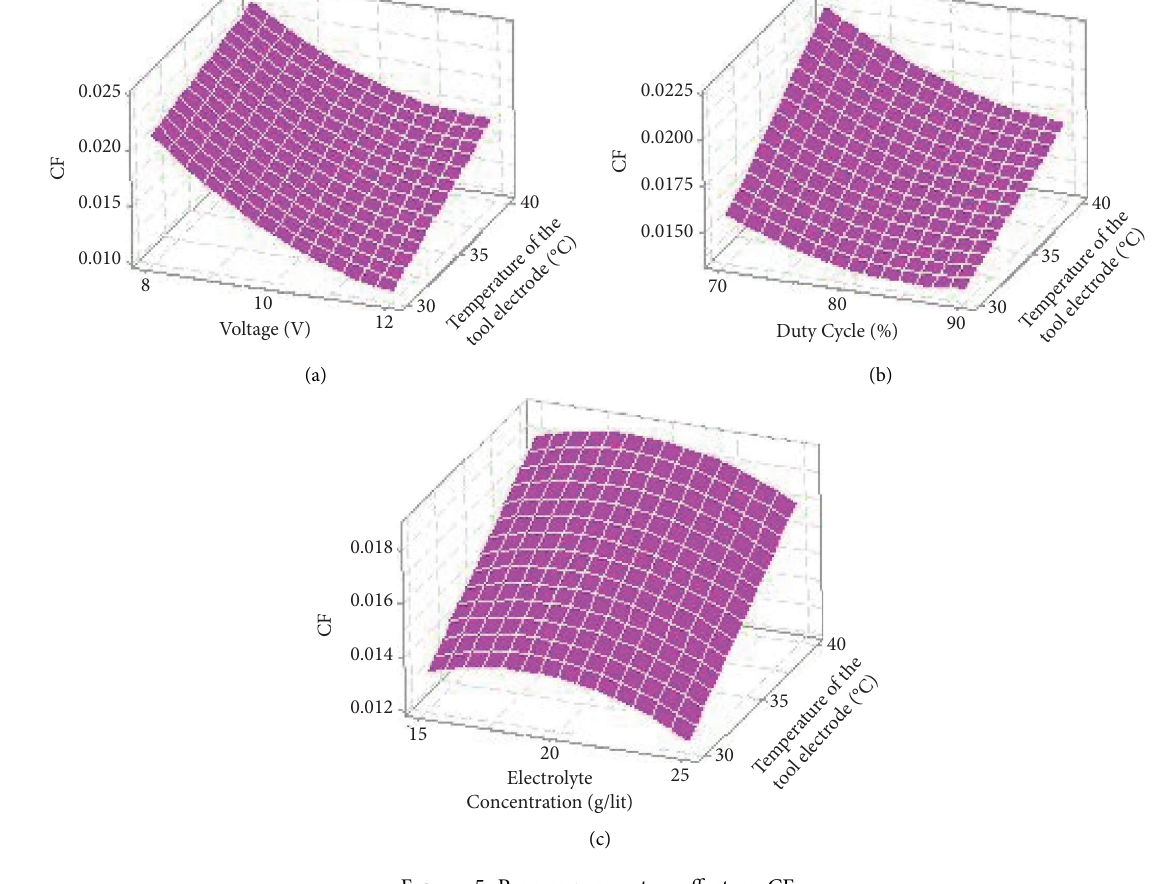
Figure 5: Process parameters efect on CF.